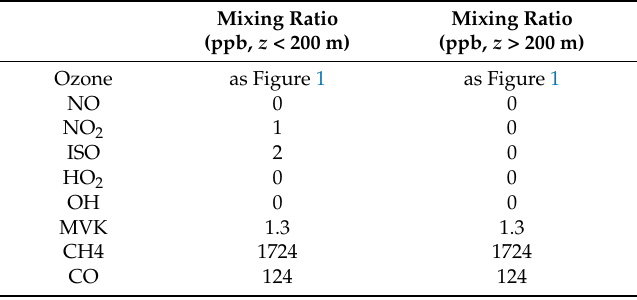
Table 3. Initial inputs of reactive chemicals for all four cases. The rest of the chemical species are set to zero.